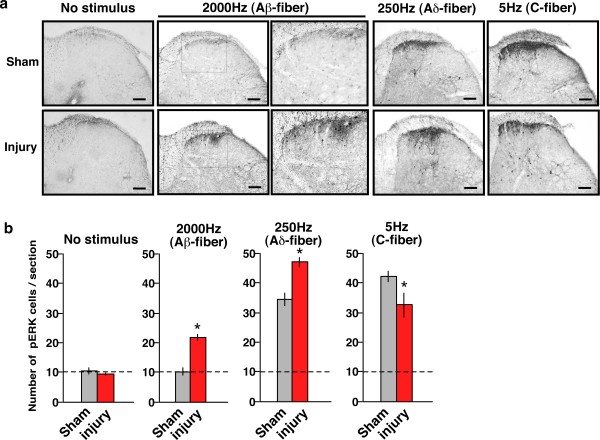
Altered pERK signals in the spinal dorsal horn induced by Aβ-, Aδ-, and C-fiber electrical stimulation in nerve-injured mice. (a) Representative pictures of pERK signals in the ipsilateral spinal dorsal horn after electrical stimulation to the right hind paw. (b) Results of pERK quantification in the spinal dorsal horn. *: p < 0.05 vs. sham. Data represent the means ± S.E.M. from experiments using at least 6 mice. Scale bar = 100 μm.